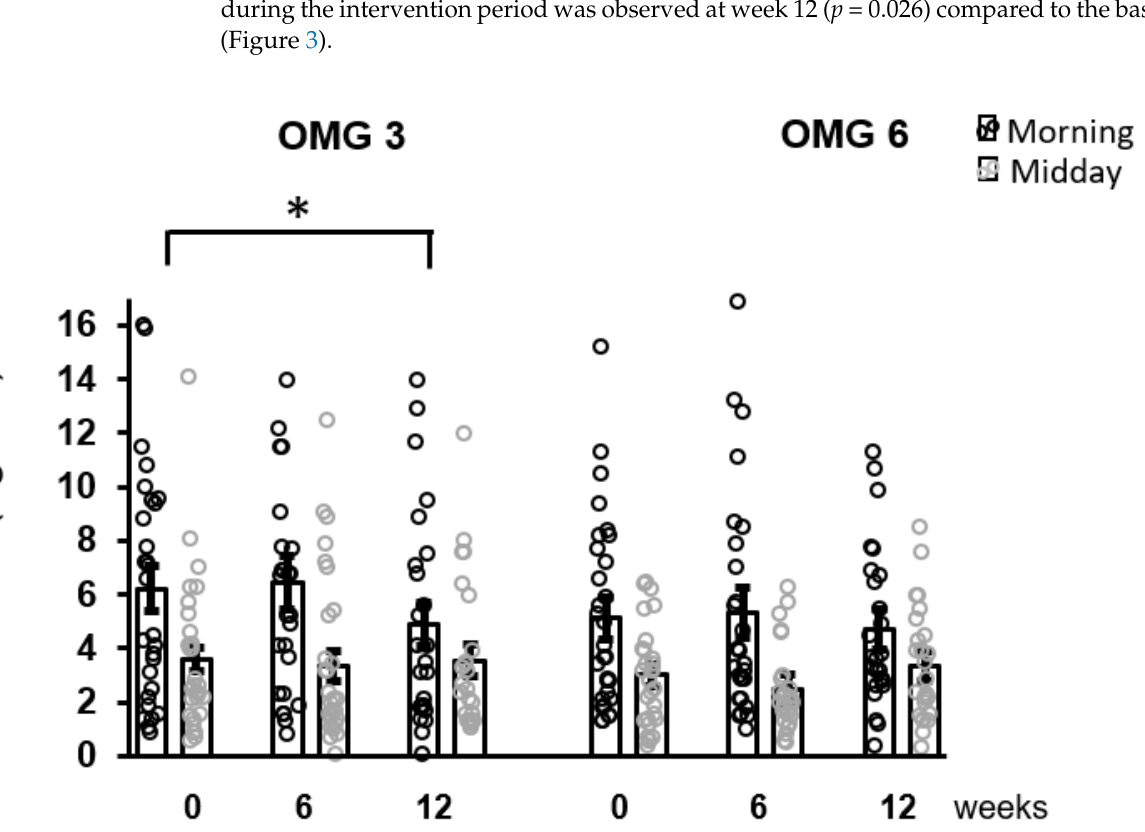
Figure 3. The effect of fatty acids supplementation on salivary cortisol concentrations in the whole sample of patients. A decrease in morning cortisol concentrations as revealed by Conover pairwise comparison test: * p < 0.05. Results are expressed as dot plots with each dot representing an